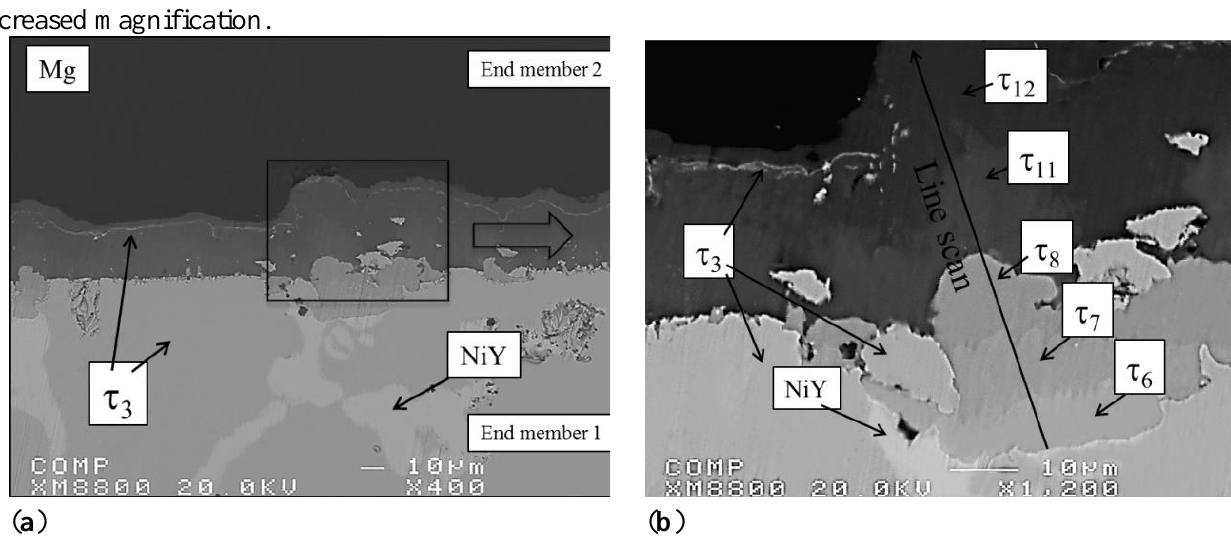
Figure 7. ( a ) BSE images of the solid-solid diffusion couple-3 annealed at 673 K for 4 weeks; ( b ) Magnified area of